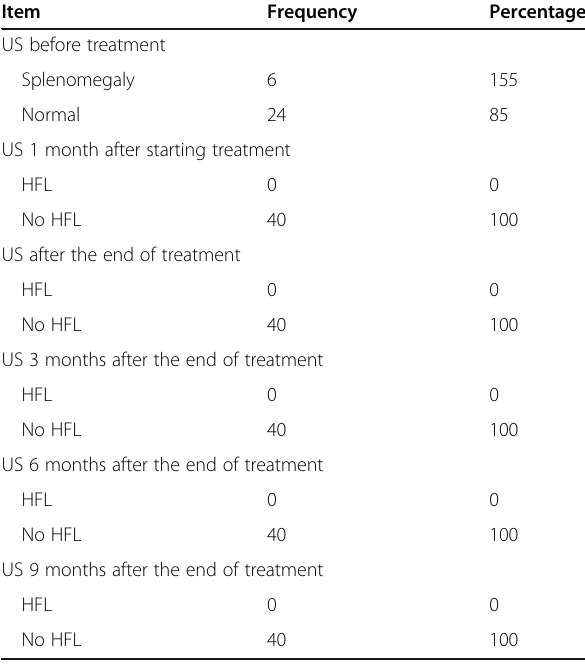
Table 3 Ultrasonographic changes during the course of treatment